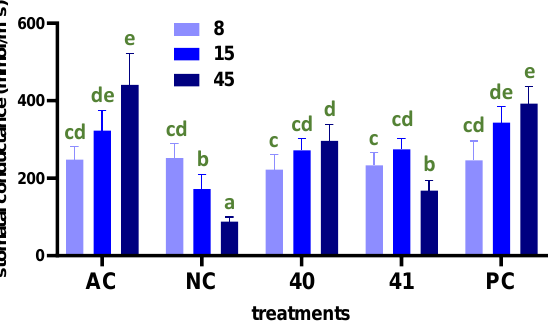
Figure 3. Effects of 40 , 41 , and the commercial fungicide (propiconazole) as the positive control (PC) on the stomatal conductance (SC) of Fusarium oxysporum- infected cape gooseberry ( Physalis peruviana L.) plants at 8, 15, and 45 dai compared to negative (NC) and absolute (AC) controls. Data are expressed as the mean ± standard deviation of six biological replicates (plants) and three technical replicates per treatment (n = 18). Different green lowercase letters over bars indicate statistically significant differences according to the Tukey test ( p < 0.05).